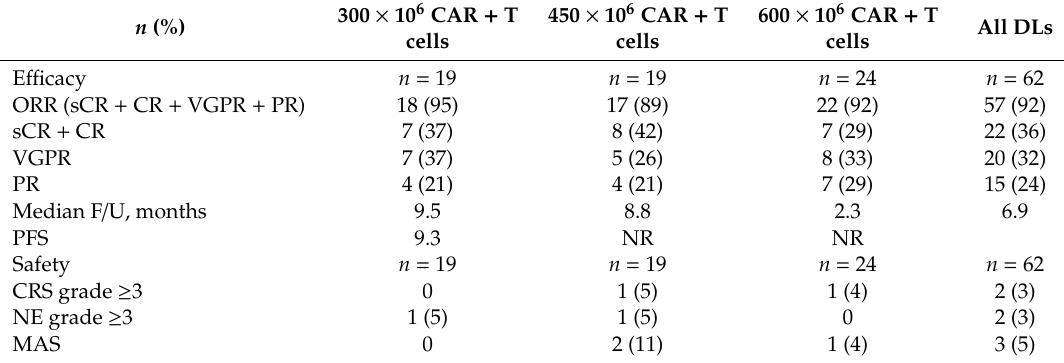
Table 4. E ffi cacy and safety data from the EVOLVE